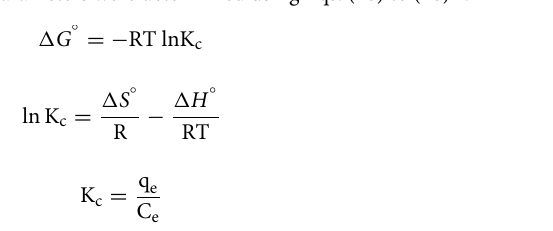
Figure 8b and Table 5 show the data obtained from the study of adsorption kinetic in the nonlinear form of the models. As can be seen, the experimental data are well consistent with the pseudo-second-order nonlinear model (R 2 = 0.9822), which indicates that the chemical adsorption mechanism dominates the adsorption process 60 . The results of recent studies show that As(V) adsorption on MOFs (Fe/Mg-MIL-88B(n) 75 , Fe–Co MOF-74 52 , Fe/Al- BDC-NH 2 76 and UiO-66/PAN membrane 77 ) is generally well described by pseudo-second-order kinetic model.